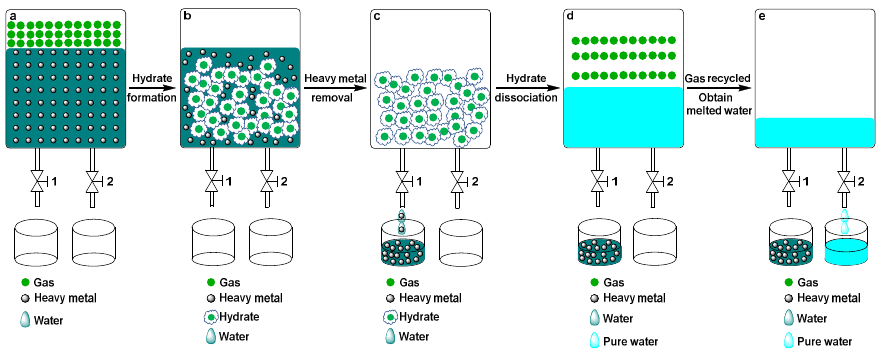
Figure 1. Schematic diagram of heavy metal separation from aqueous solution. ( a ) Before of hydrate formation; ( b ) Hydrate formation; ( c ) Heavy metal removal; ( d ) Hydrate dissociation; ( e ) Gas recycled and obtain melted water.